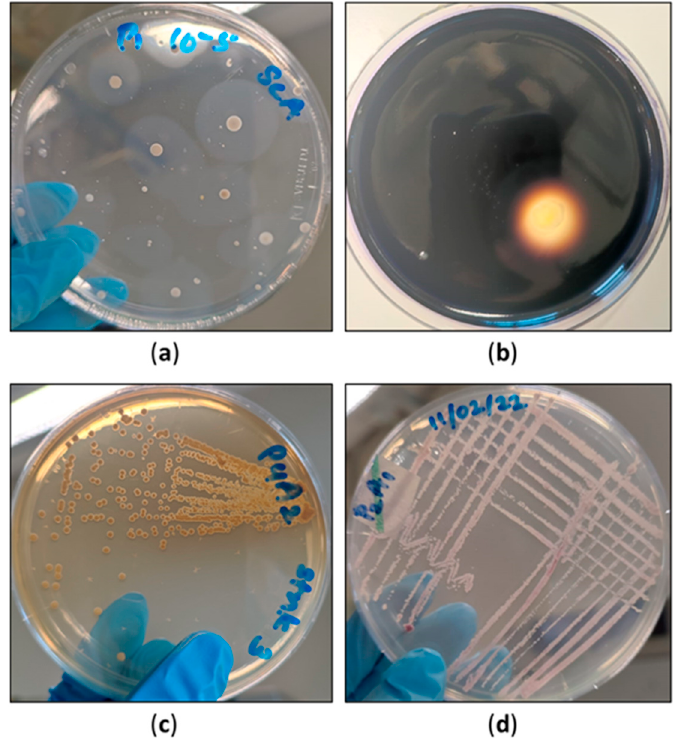
Figure 6. ( a ) Halozones developed due to starch hydrolysis by the bacteria grown on starch casein agar; ( b ) Visible clear zone around an actinomycete colony after the addition of iodine; ( c ) Pigmented actinomycete isolate obtained from the cutaway site in April; ( d ) Pigmented actinomycete isolate obtained from the cutaway site in January.